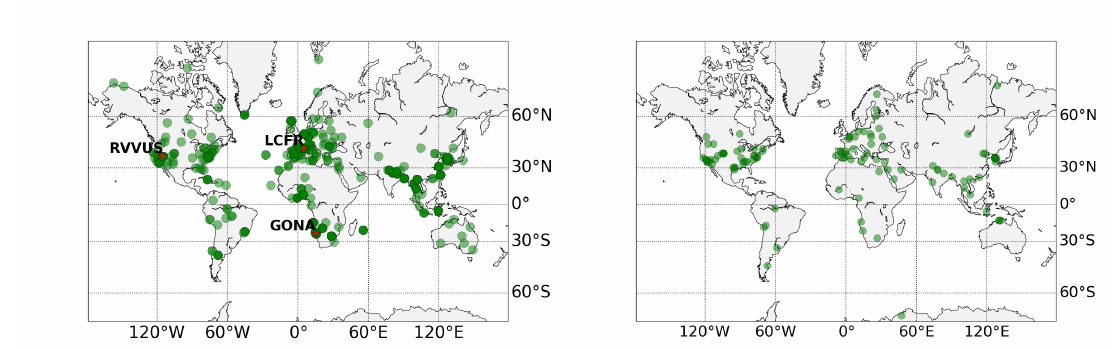
Figure 2. Distribution of the AERONET stations (green circles) used in the Sentinel-2 ( left ) and Landsat-8 ( right ) validation study. The RadCalNet sites used for the Sentinel-2 surface reflectance validation are shown in the left plot (red stars): RailroadValley Playa (RVUS), La Crau (LCFR), and Gobabeb